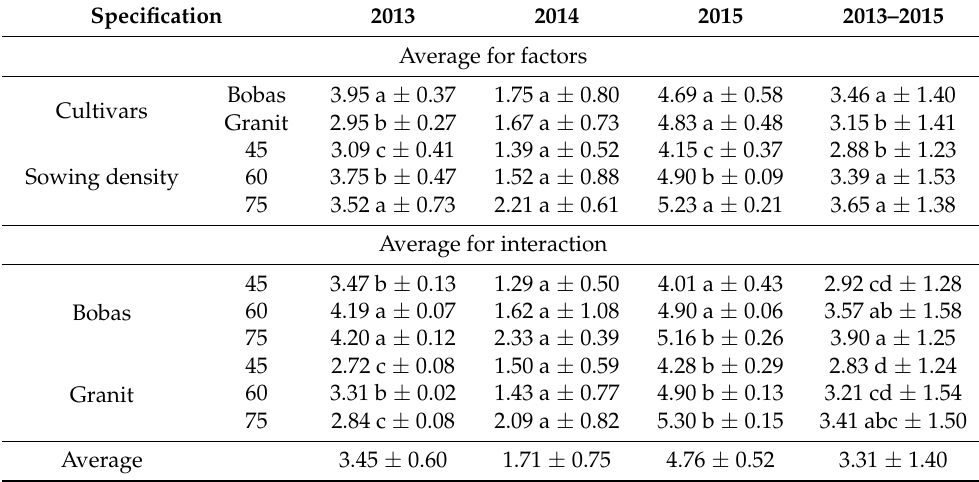
Table 10. Calcium accumulation in the faba bean seeds (kg ha − 1 ) as influenced by the examined factors during the study years 2013–2015.